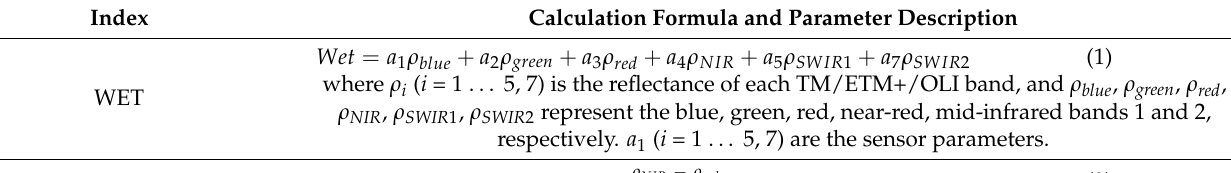
Table 5. Calculation formulas and description of each indicator of RSEI. Calculation Formula and Parameter